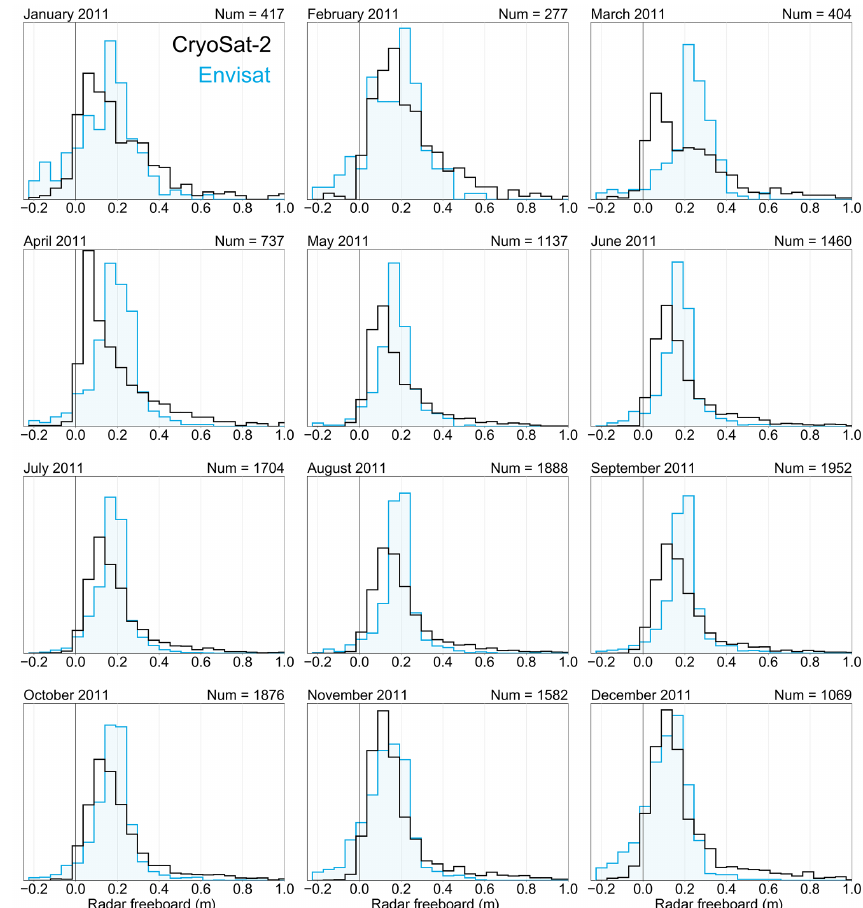
Figure 3. Histograms of freeboard distribution for CS-2 (black) and Envisat (blue) data. Only data occurring in both data sets have been considered. n is the number of compared grid